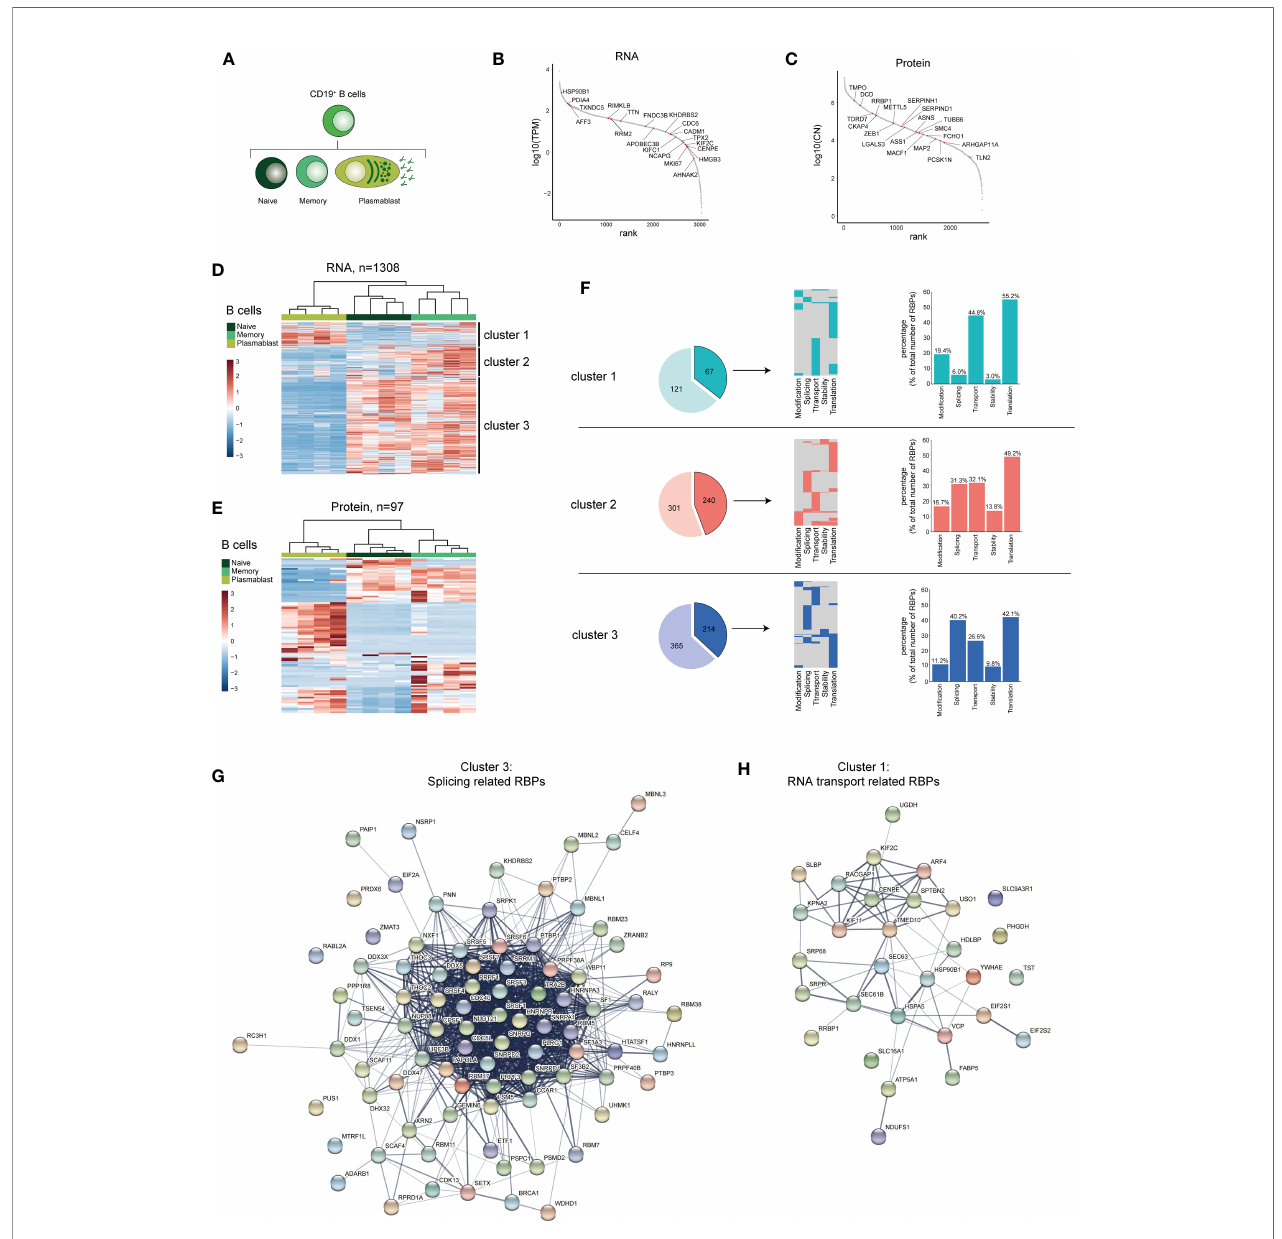
FIGURE 3 | RBP expression alters upon B cell differentiation. (A) Diagram depicting the analysed CD19 + B cell subsets. (B, C) Expression levels of RBPs detected in B cells at RNA level (B) and at protein level (C) , ranked according to expression levels. Red dots indicate the top 20 most differentially expressed RBPs, ranked on Log2 Fold Change). (D, E) Heatmap of unsupervised clustering of DE RBPs at mRNA (D) and at protein level (E) between naive CD19 + B cells, memory CD19 + B cells and plasmablasts. n=4 donors. (F) Left panels: RBPs annotated for RNA splicing, stability, subcellular localization of RNA, RNA modi fi cation, and translation (dark colors) or for other processes (light colors) in the three clusters de fi ned in (D) . Middle panels: relative distribution between the 5 speci fi c RBP classes. Right panels: Percentage of RBPs annotated for the indicated RNA-related biological processes. (G, H) String analysis on splicing- related RBPs (G) identi fi ed in cluster 3 and on RNA transport-associated RBPs (H) identi fi ed in cluster 1. TPM, Transcripts per kilobase per million; CN, Protein copy